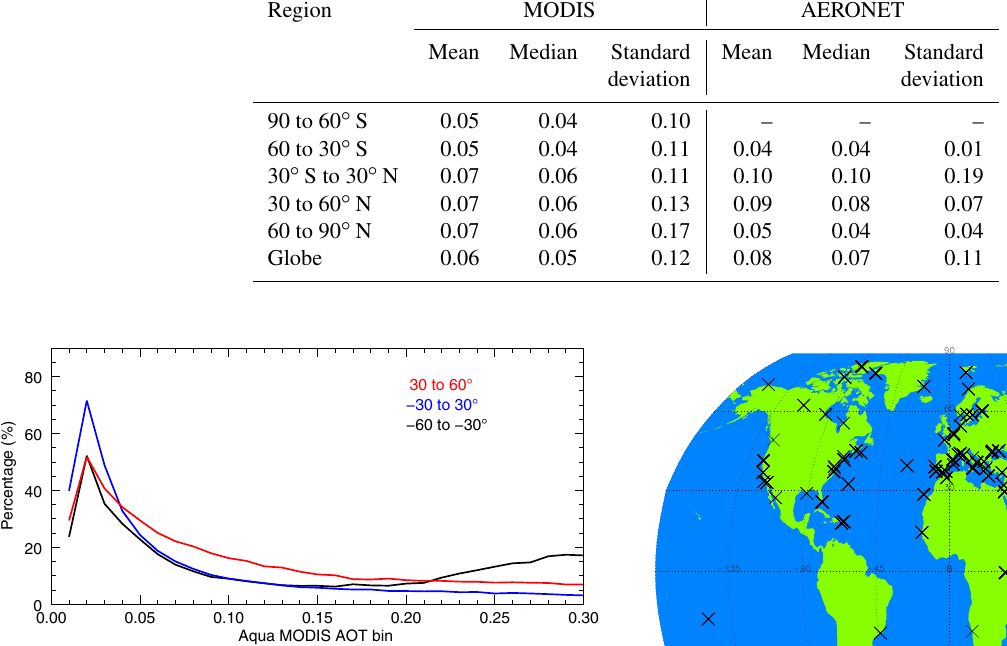
Table 2. Mean, median, and standard deviation of AOTs derived from Aqua MODIS (2010–2011) and AERONET (2007–2008; 2010–2011), both independently collocated with CALIOP all-RFV profiles. Region MODIS